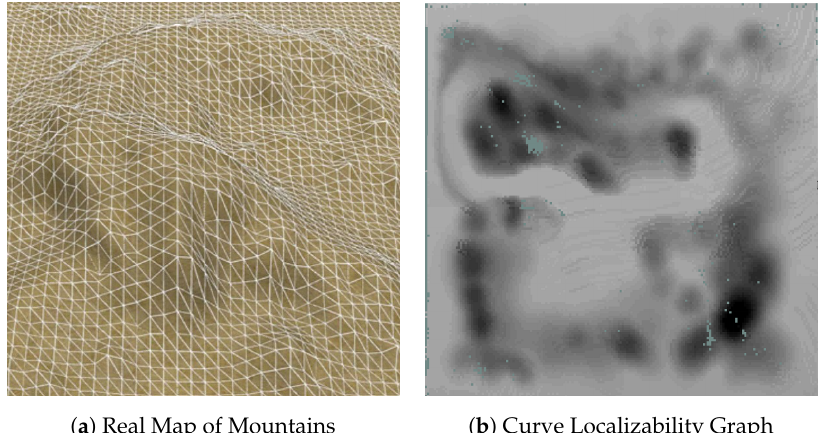
Figure 3. Sketch Graph of Curve